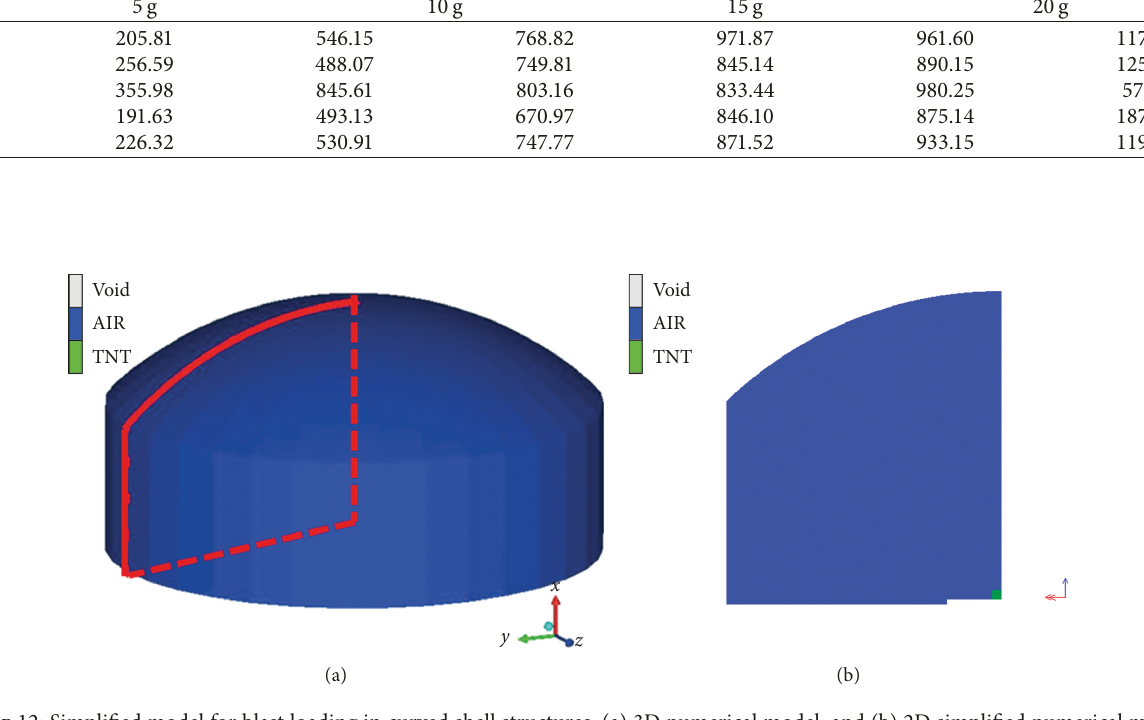
Figure 12: Simplified model for blast loading in curved shell structures. (a) 3D numerical model, and (b) 2D simplified numerical